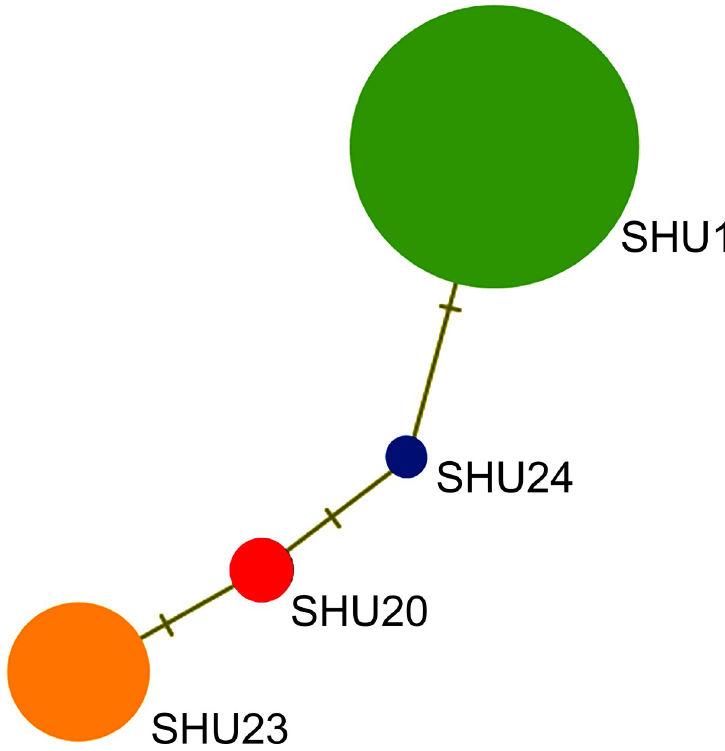
Fig 3. Haplotype network based on sequence data for the mitochondrial D-loop region of Hume’s pheasant ( Syrmaticus humiae , Hume 1881) from the captive population at the Doi Tung Wildlife Breeding Center.